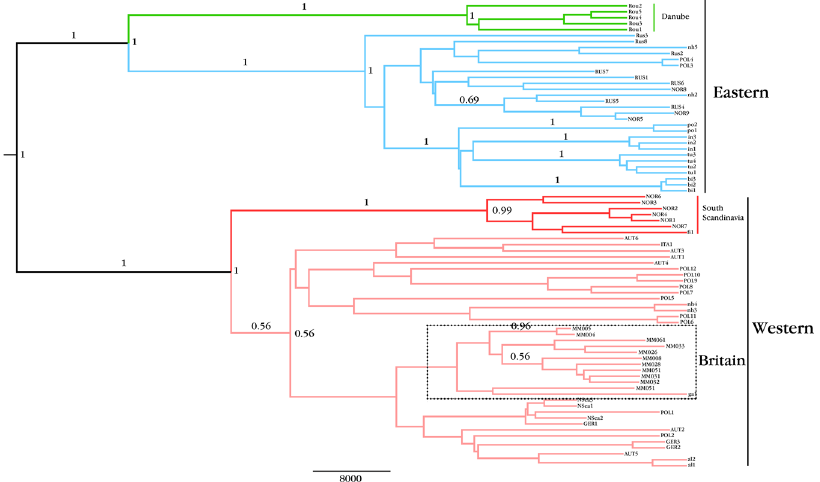
Figure 3. Phylogenetic relationships among ancient British and modern and ancient beavers. Shown is a maximum clade credibility (MCC) tree, generated in BEAST 47 with partial (492 bp) tRNA-Pro/control region haplotypes, with British samples highlighted in the dashed box. Only node and branch posterior probability values above 0.5 are shown. The genealogy was generated using a Strict Molecular Clock with a fixed rate of nucleotide substitution set to 5.0 × 10 − 7 and a coalescent expansion model of demography. The tree shows the British samples group within the large Western clade with no posterior support for genetic